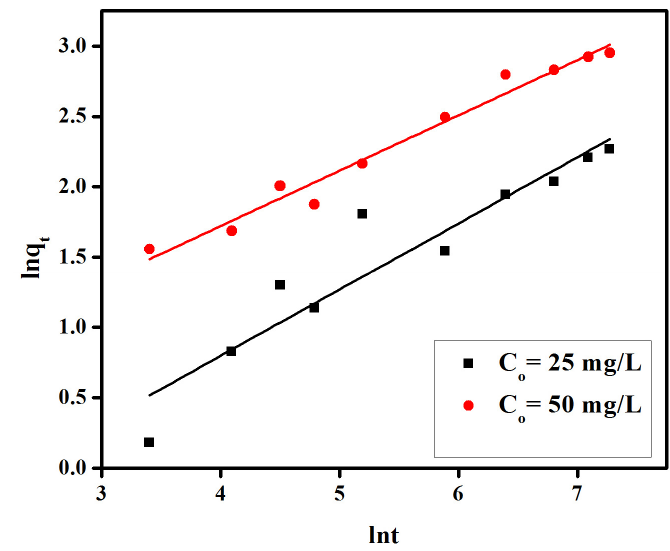
Figure 11. The modified Freundlich plot of ln t vs . ln qt for adsorption of congo red on anion exchange membrane